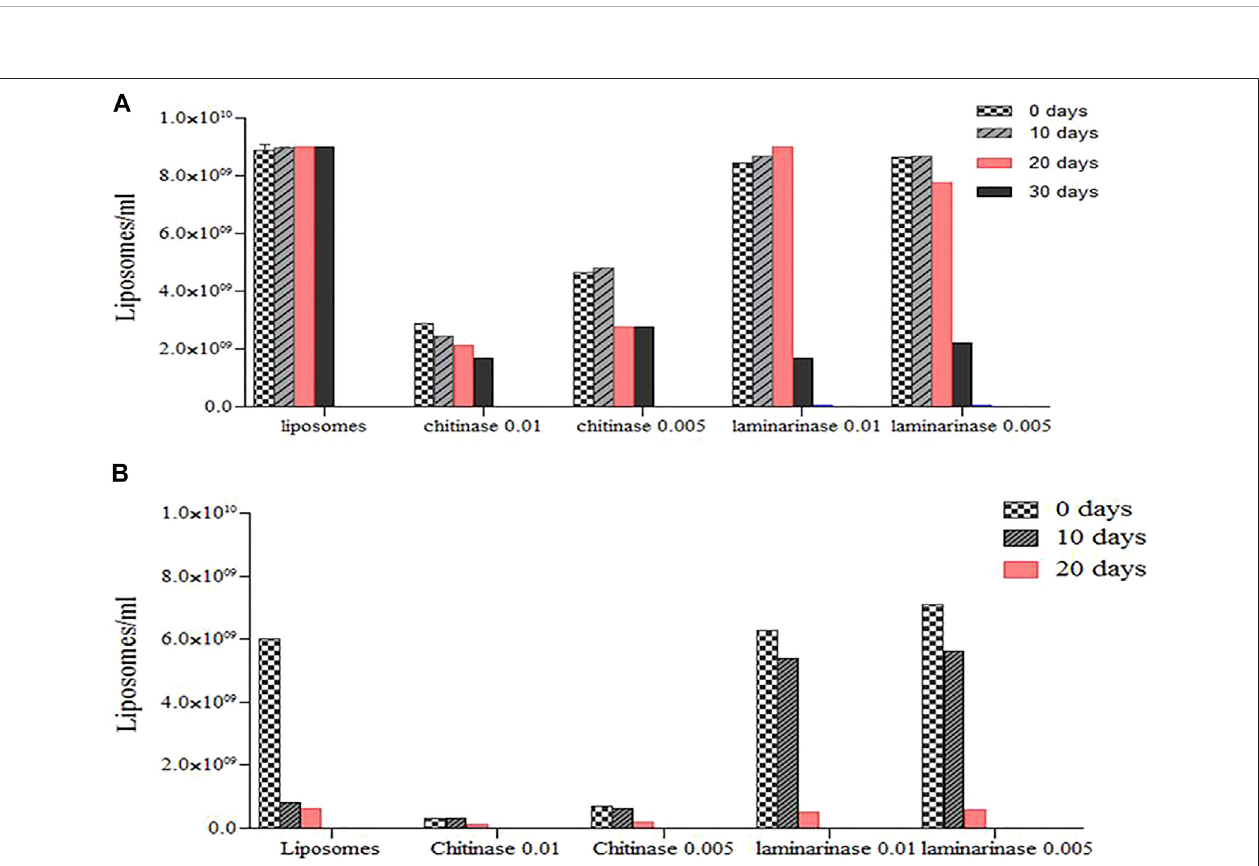
FIGURE 5 | Concentration of enzyme (Chitinase at 0.01 mg/ml and Laminarinase at 0.01 mg/ml) loaded liposomes during long-term (10, 20 and 30 d) storage at diferentstemperature: (A) ,T − 4 ° Cand (B),T − 25 ° C.Quanti fi cation wasperformed byopticallightmicroscopy (40X)(Cano-Salazaret al.,2011;Pérez Molinaetal.,2011).